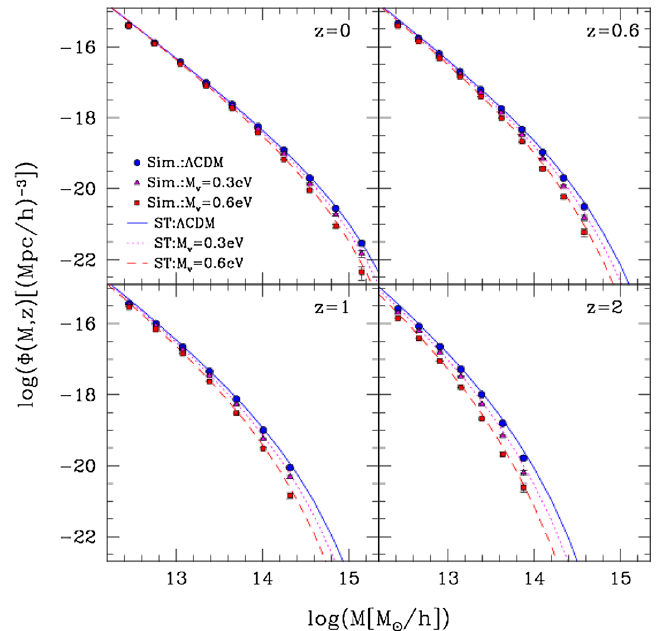
Fig. 43 DM halo mass function (MF) as a function of Σ and redshift. MF of the SUBFIND haloes in the Λ CDM N -body simulation (blue circles) and in the two simulations with Σ = 0 . 3 eV (magenta triangles) and Σ = 0 . 6 eV (red squares). The blue, magenta and red lines show the halo MF predicted by Sheth and Tormen (2002), where the variance in the density fluctuation field, σ( M ) , at the three cosmologies, Σ = 0 , 0 . 3 , 0 . 6 eV, has been computed with the software camb (Lewis et al.